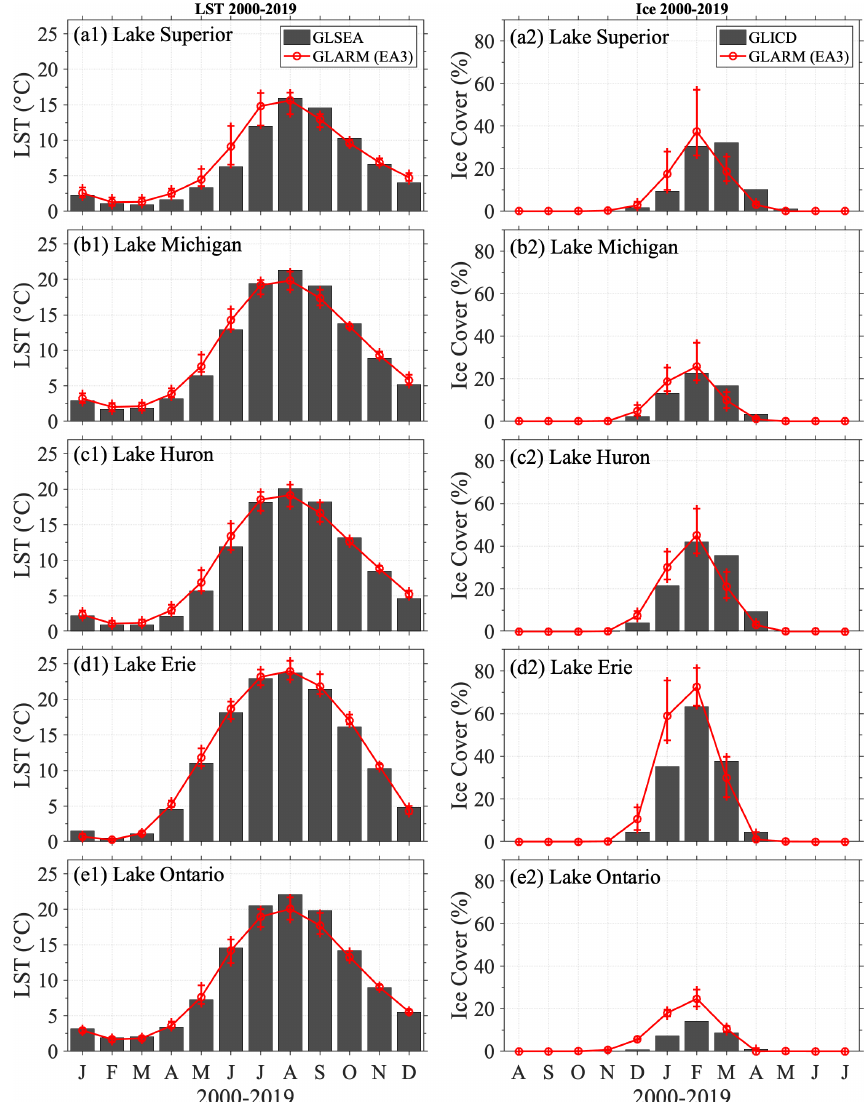
Figure 5. Monthly climatologies (2000–2019) of LST (left panels) and monthly mean ice cover (right panels) in the five Great Lakes. The GLSEA LST and GLICD ice cover are shown as bar plots, and the GLARM-EA3 simulations are shown as red lines. The red error bars indicate the range of the three individual GLARM